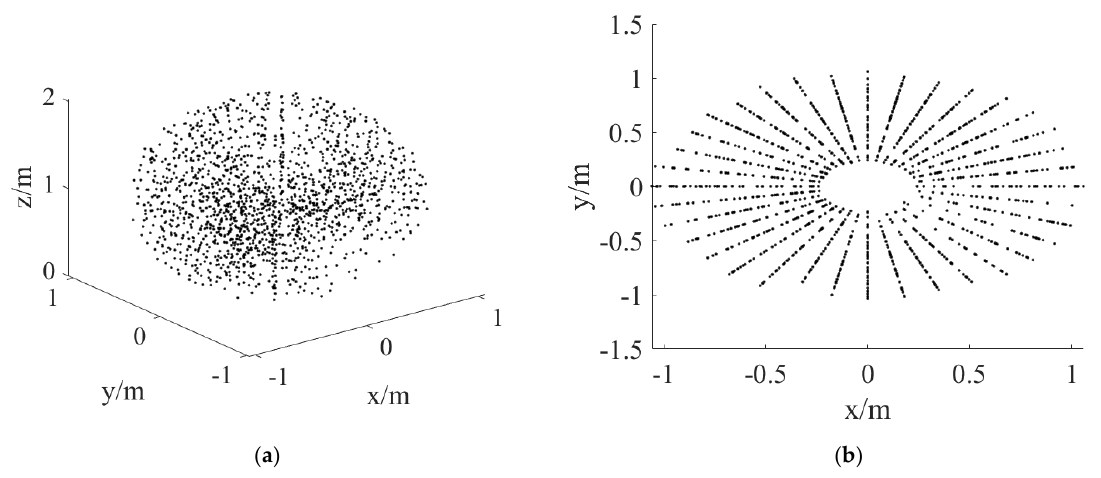
Figure 6. The work space of the manipulator in Cartesian space. ( a ) 3D view; ( b ) top view.